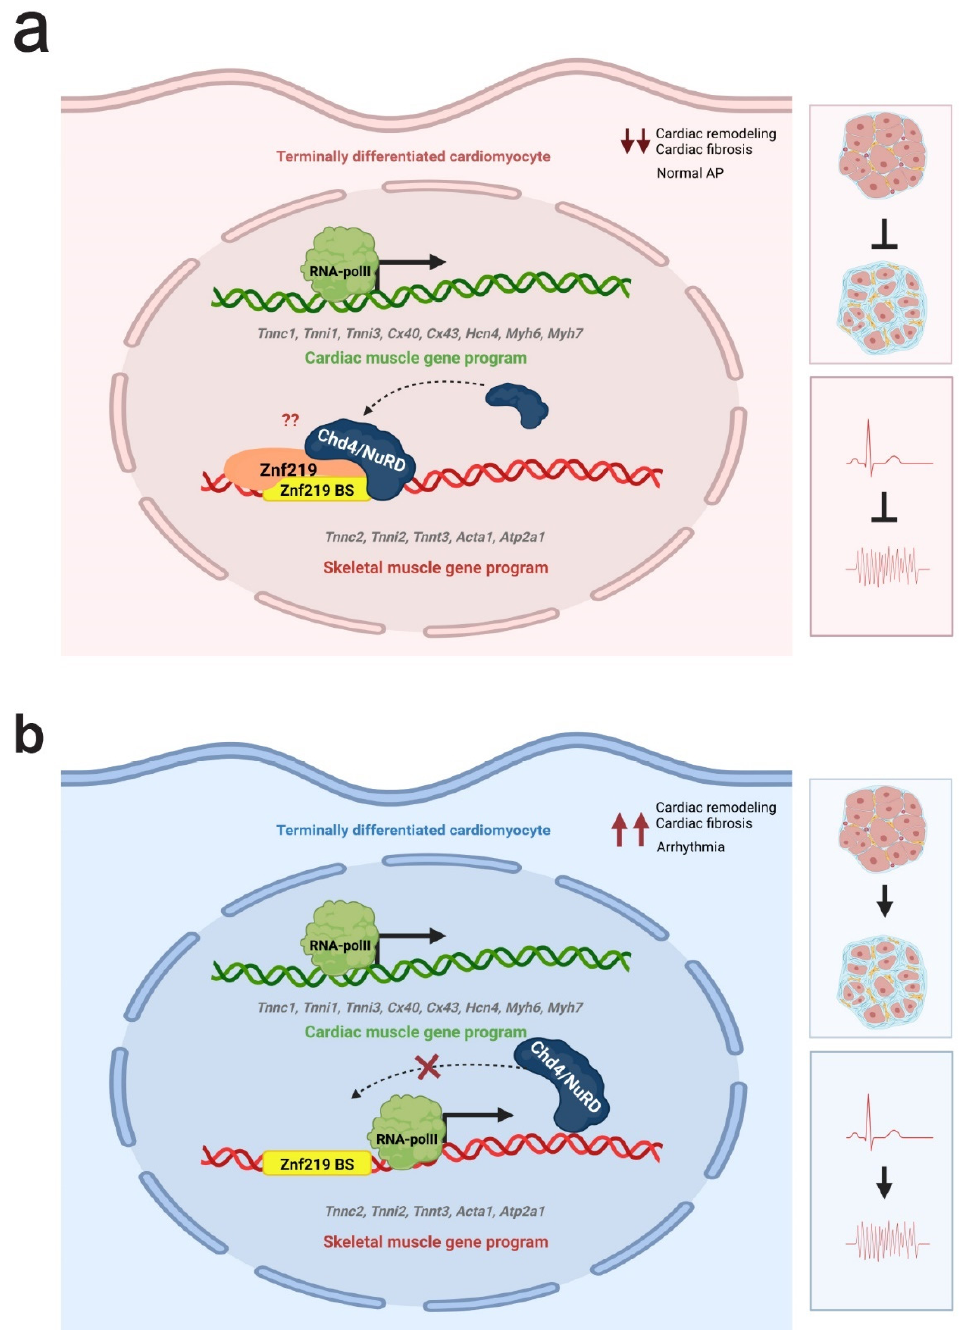
Figure 6. Model of the function of Znf219 in the mammalian heart. Proposed model of Znf219- Chd4/NuRD interplay in cardiac regulation. ( a ) Znf219/Chd4 complexes silence the expression of the skeletal-muscle gene program in cardiac tissue. ( b ) In the absence of Znf219 or Chd4, the skeletal-muscle gene program is activated ectopically in the heart, leading to fibrosis, conformational arrhythmias, and cardiac remodeling. This figure was created with biorender.com.